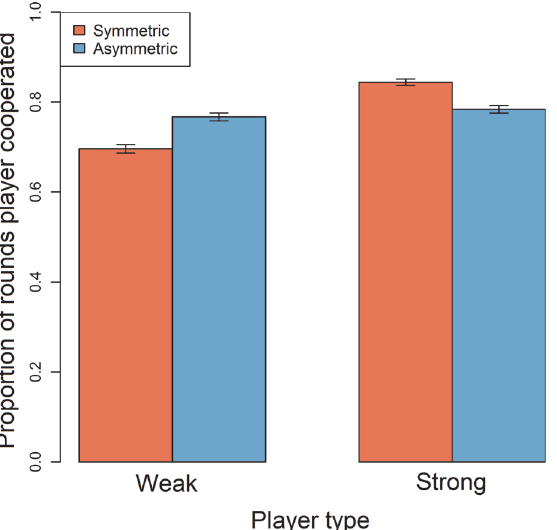
Fig 1. Barplot showing the proportion of rounds which players cooperated in symmetric (red bars) and asymmetric (blue bars) games according to whether they were weak or strong. Data exclude rounds where either player opted out or was bankrupt. Error bars represent standard errors. Plots are generated from raw